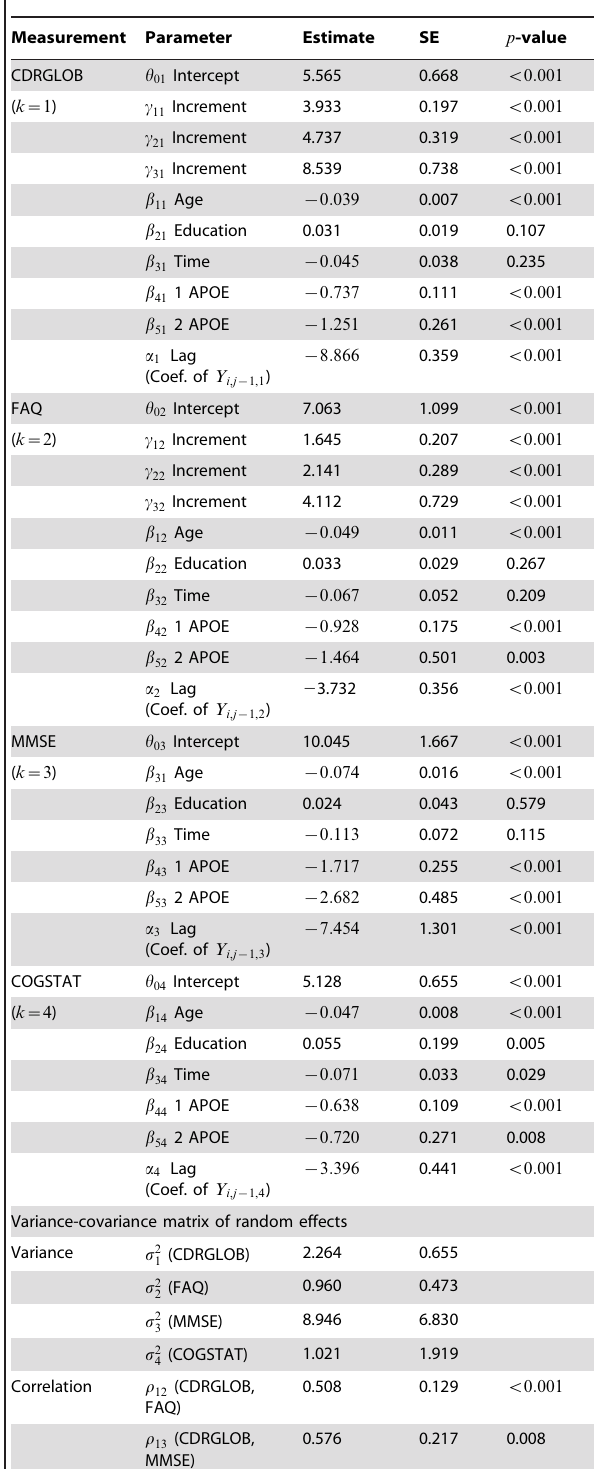
Table 1. Analysis results of the Uniform Data Set in the National Alzheimer’s Coordinating Center (four measurements): parameter estimates, sandwich estimators of variance (standard deviations) and covariance, and the p - values of Wald tests.